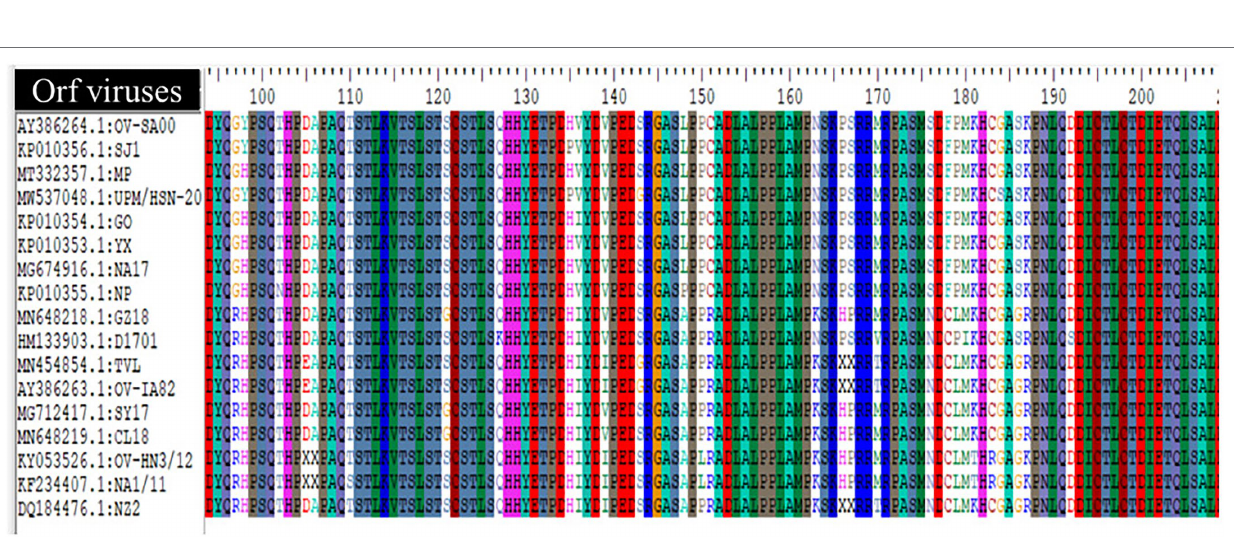
FIGURE 5 | Multiple alignment of deduced amino acid sequence (ORF117) of Orf virus UPM/HSN-20 and other reference